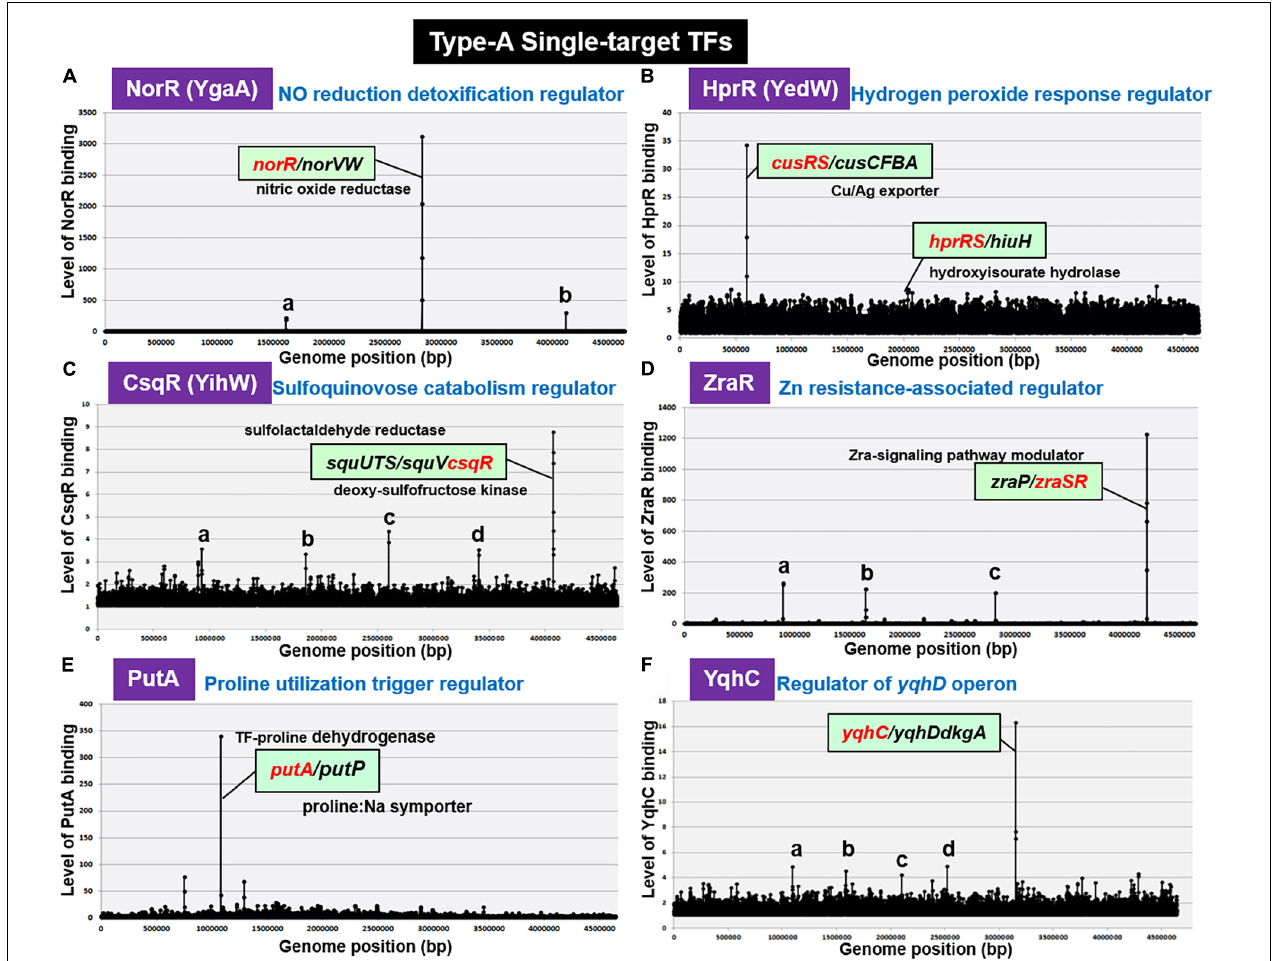
FIGURE 2 | gSELEX patterns of novel type-A ST-TFs. (A) NorR (renamed YgaA). Two minor peaks represent: a. spacer ( sad/yneJ ); and b. spacer ( glpF/zapB ). (B) HprR (renamed YedW). The hprR gene itself forms a minor peak. (C) CsqR (renamed YihW). Four minor peaks represent: a. ORF ( trxB ); b. ORF ( yeaC ); c. ORF ( hyfB ); and d. ORF ( accC ). (D) ZraR. Three minor peaks represent: a. spacer (-/ potF ); b. spacer ( relB/ydfV ); and c. spacer ( mltB/selA ). (E) PutA. (F) YqhC. Low-level peaks with weak binding affinity to test ST-TFs disappeared after repeated gSELEX screening (for instance see Shimada et al.,